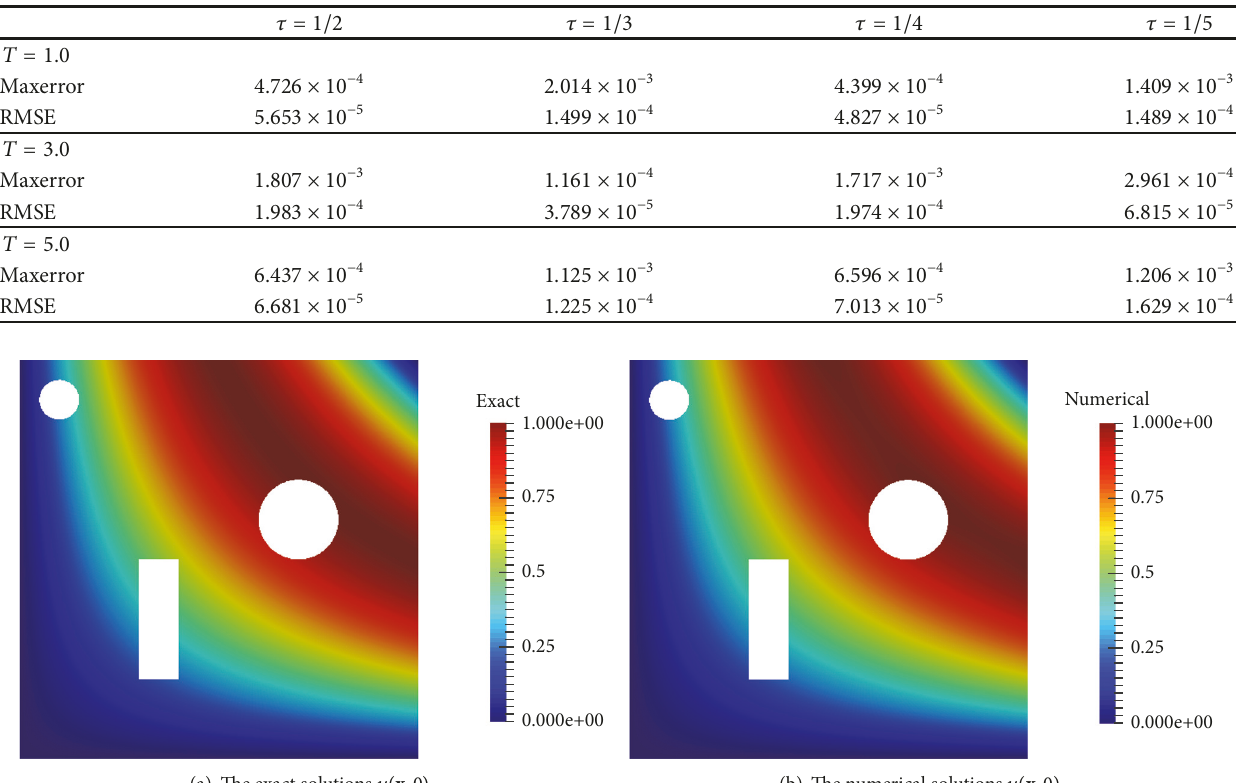
Table 5: Maxerror and RMSE for 𝑇 = 1,3,5 with different 𝜏 .